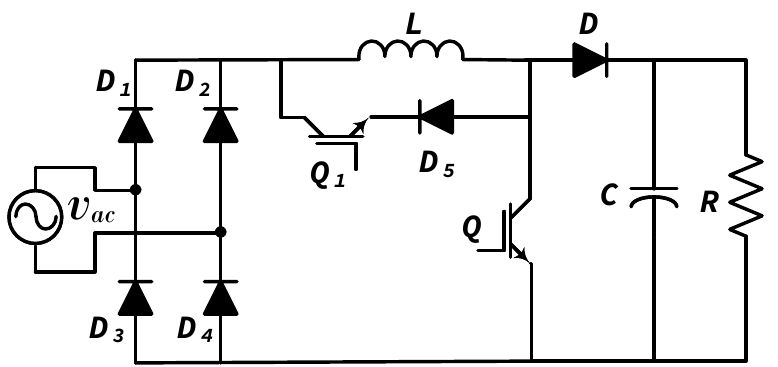
Figure 2. Conventional PFC topology with pseudo-continuous conduction.